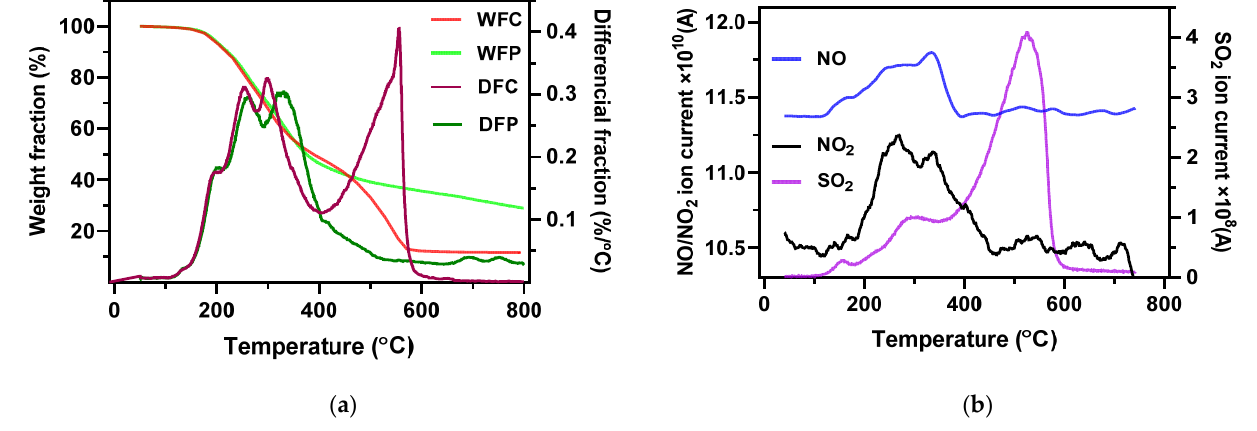
Figure 3. ( a ) Weight fraction and differential weight fraction as a function of temperature during pyrolysis and combustion of the AMR (WFC—weight fraction during combustion, WFP—weight fraction during pyrolysis, DFC–differential weight fraction during combustion, and DFP—differential weight fraction during pyrolysis). ( b ) The emission intensity of NO, NO 2 , and SO 2 during AMR combustion in Ar/O 2 atmosphere.